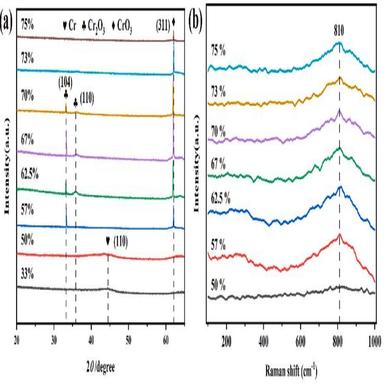
XRD and Raman spectra of chromium oxide thin films under different oxygen partial pressures a) XRD spectra b) Raman spectra.